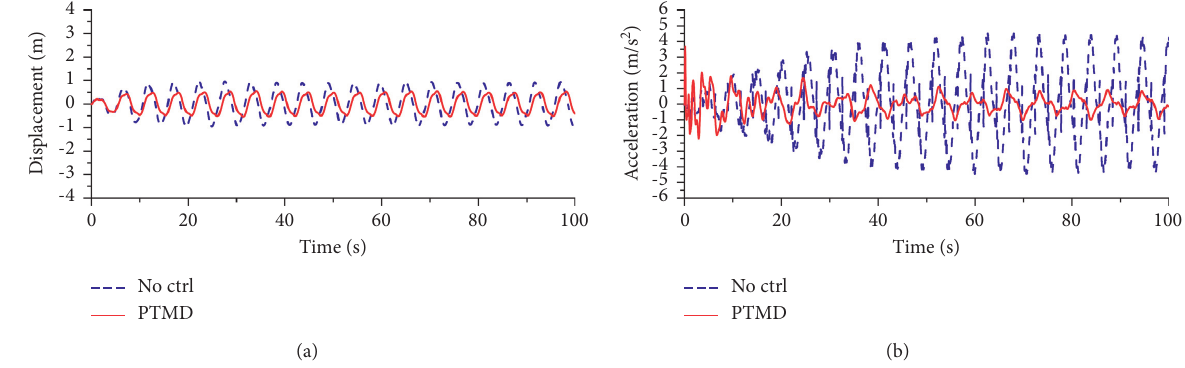
Figure 9: : Maximum response of the SCR under OC3: (a) displacement and (b) acceleration.